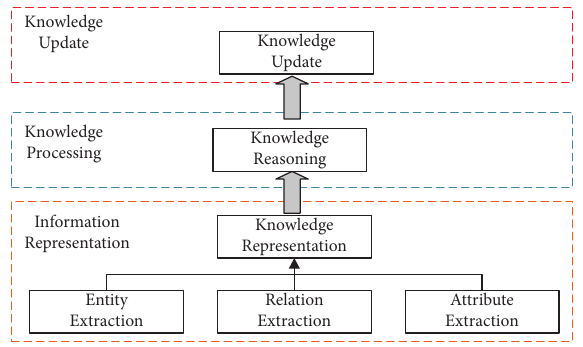
Figure 3: Construction of multimodal knowledge graph.